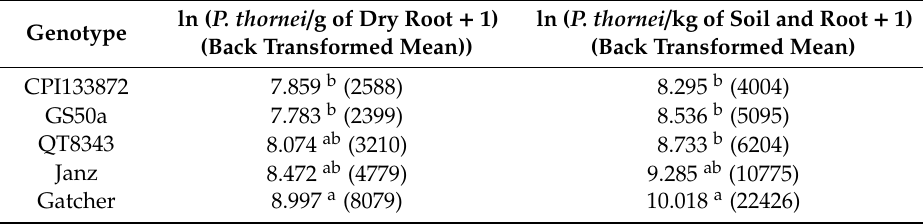
Table 1. Total Pratylenchus thornei numbers (natural log transformed mean value) in different wheat genotypes at 10 weeks post-nematode inoculation.